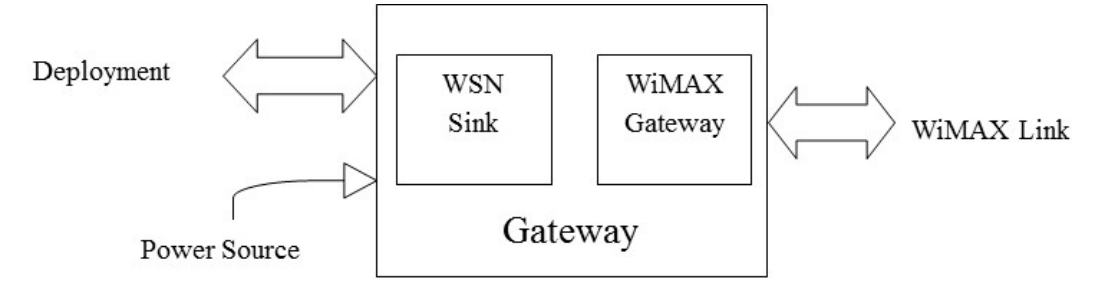
Figure 2. Block schematic of the gateway.